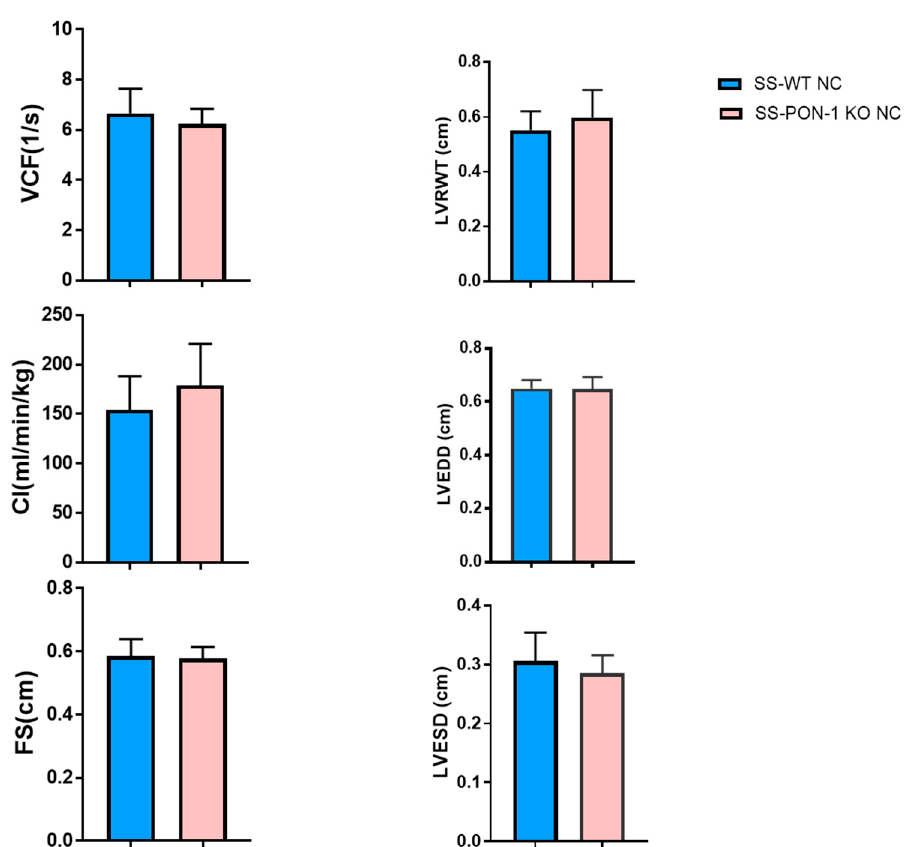
Figure 1. Echocardiographic evaluation at baseline (on normal chow) shows no differences in left ventricular geometry as well as in global systolic function ( N = 8). Data are presented as the mean ± standard error of the mean. Student’s unpaired t -test was used to assess statistically significant differences between the groups. VCF: velocity of circumferential fiber shortening, CI: cardiac index, FS: fractional shortening, LVRWT: left ventricular relative wall thickness, LVEDD: left ventricular end-diastolic dimension, LVESD: left ventricular end-systolic dimension.